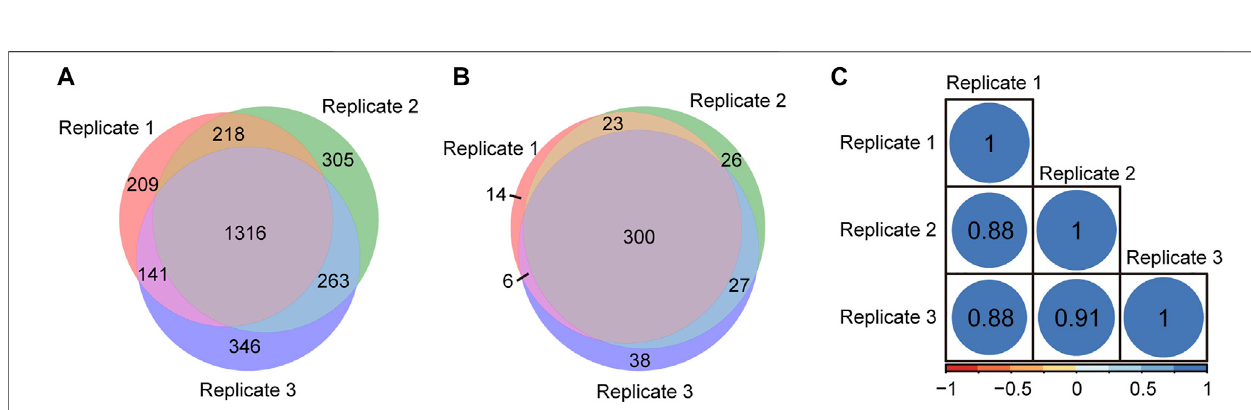
Frontiers in Molecular Biosciences |